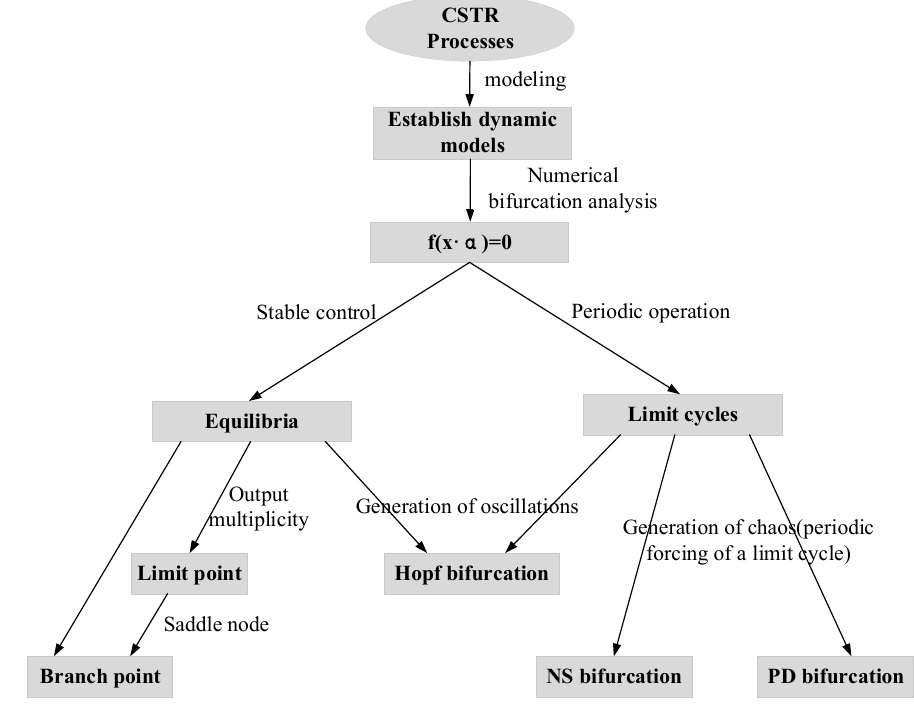
Figure 1. Schematic of the strategy for analyzing continuous stirred tank reactor (CSTR) dynamic behaviors.